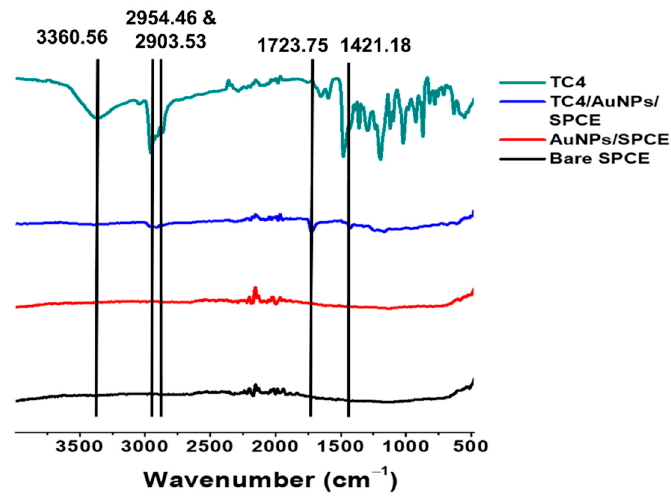
Figure 1. The FTIR spectra of the bare screen-printed carbon electrode (SPCE), gold nanoparticles/screen-printed carbon electrode (AuNPs/SPCE), thiolated calix[4]arene/gold nanoparticles/screen-printed carbon electrode (TC4/AuNPs/SPCE), and TC4 solid compound.